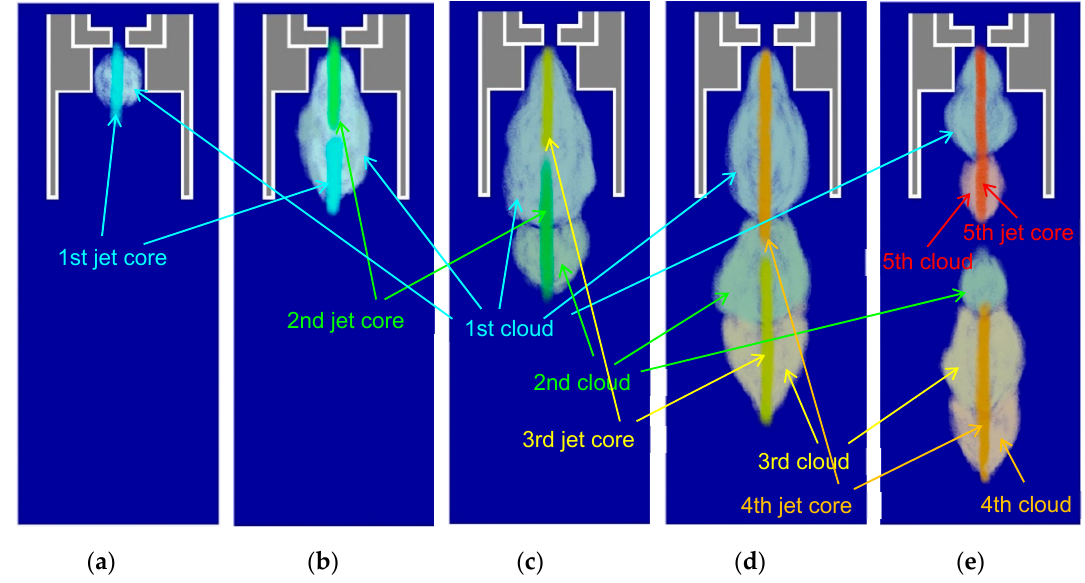
Figure 7. Schematic diagram of the development of cavitation cloud in cavitating jet: ( a ) 1st cloud produced by the 1st jet core; ( b ) 2nd jet core passing through the 1st cloud; ( c ) 2nd cloud produced by the 2nd jet core and 3rd jet core passing through the 1st cloud; ( d ) 3rd cloud produced by the 3rd jet core and 4th jet core passing through the 1st and 2nd clouds; ( e ) 4th cloud produced by the 4th jet core, and 5th cloud produced by 5th jet core passing through the 1st clouds.